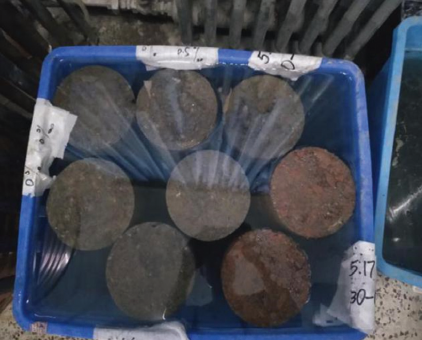
Figure 9: Water immersion specimens.